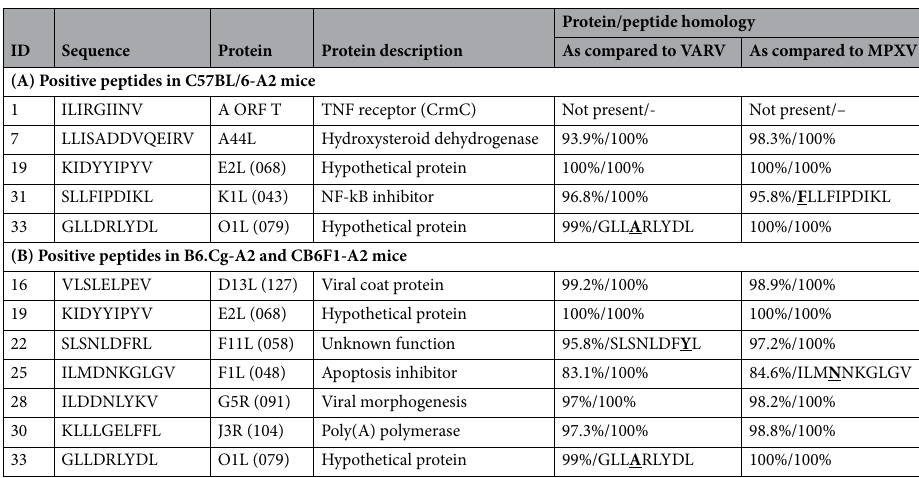
Table 1. Positive peptides in 3 different strains of female transgenic mice carrying human HLA-A2 gene. Five (5) positive peptides were identified in C57BL/6-A2 mice model (A) while identical seven (7) positive peptides were identified in both B6.Cg-A2 and CB6F1-A2 mice (B). “Sequence” is the amino acid sequence based on the Copenhagen strain of vaccinia virus (VACV). “Protein” is the Copenhagen designation of the protein containing the indicated peptide. The number in parentheses is the designation for the ACAM2000 homolog. “Protein description” is obtained from www. poxvi rus. org. The “Protein/peptide homology” columns list the sequence homology for the protein/peptide when compared to the sequences of Variola virus (VARV, India 1967 strain) and Monkeypox virus (MPXV, Zaire strain). Where differences occur, the VARV or MPXV sequences are listed with amino acid differences highlighted in bold and